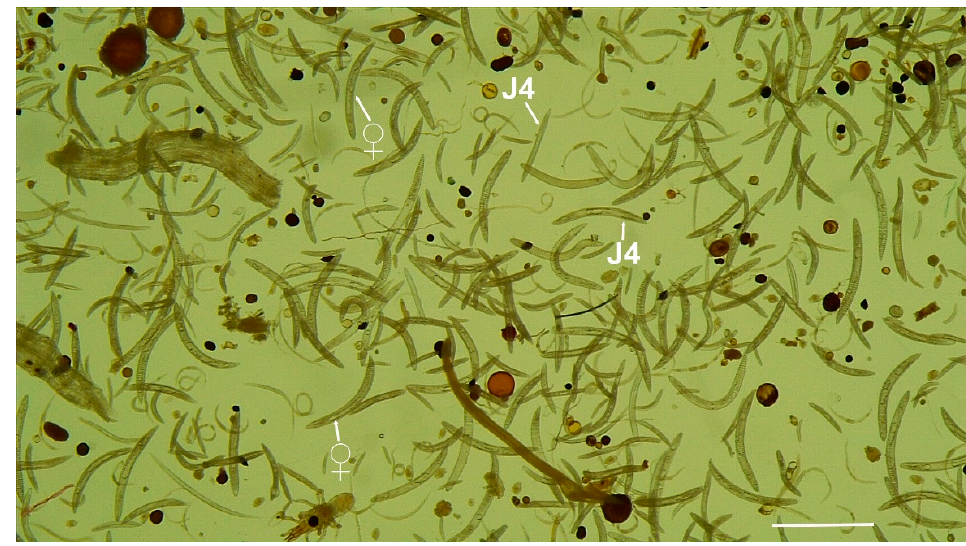
Figure 1. Soil sample extraction (500 cm 3 ) from peach in Calasparra, Murcia, Spain showing numerous female and juveniles (arrowed) of Criconema paraannuliferum sp. nov. “ ♀ ” = female, and “J4” = fourth-stage juvenile. (Scale bar = 500 µm).